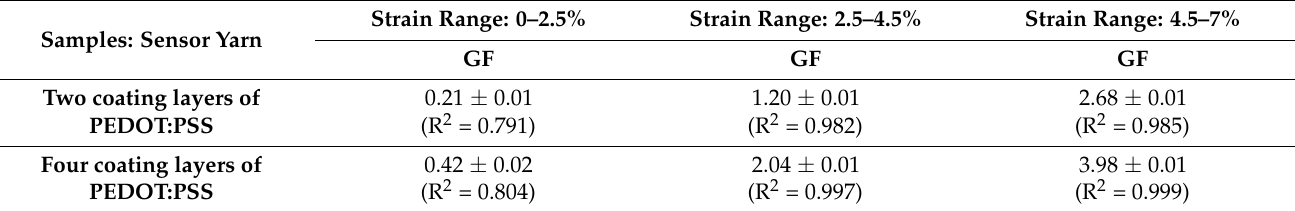
Table 2. Electromechanical characteristics of sensor yarns: gauge factor (GF) value.